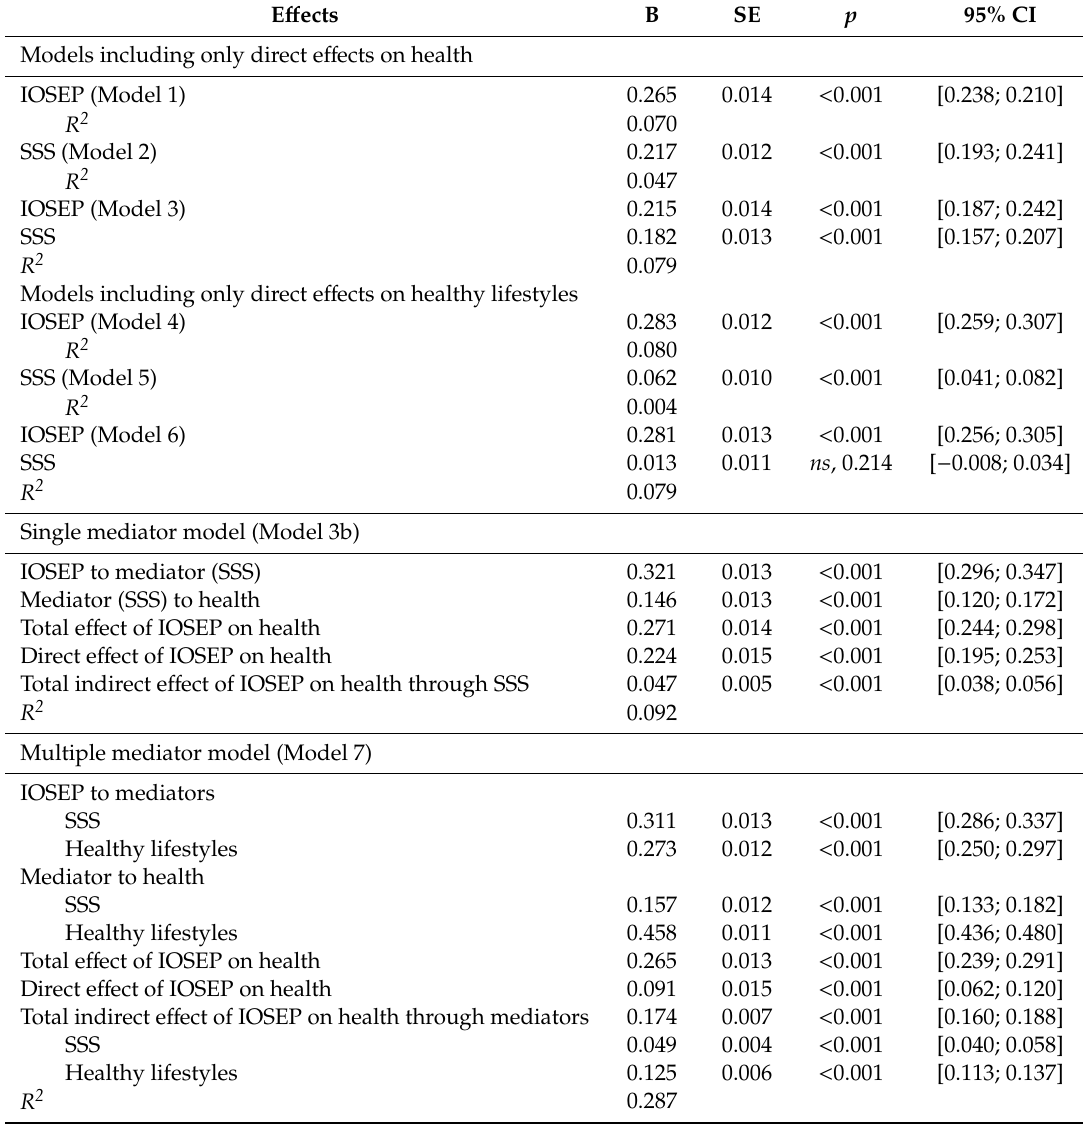
Table 6. Standardized coe ffi cients representing direct and indirect paths for the models. E ff ects B SE p 95% CI Models including only direct e ff ects on